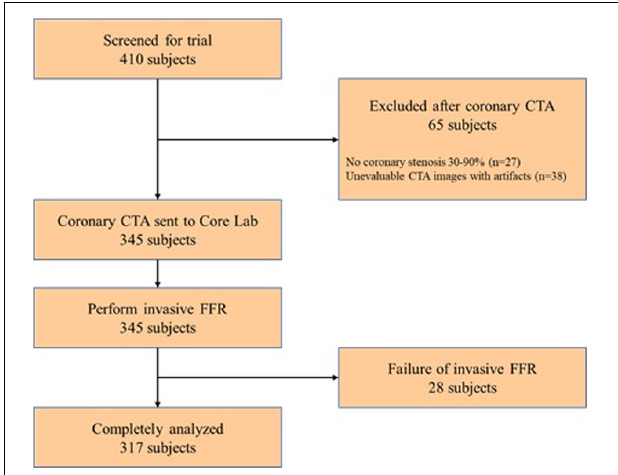
FIGURE 1 | Study flowchart. CTA, computed tomography angiography; FFR, fractional flow